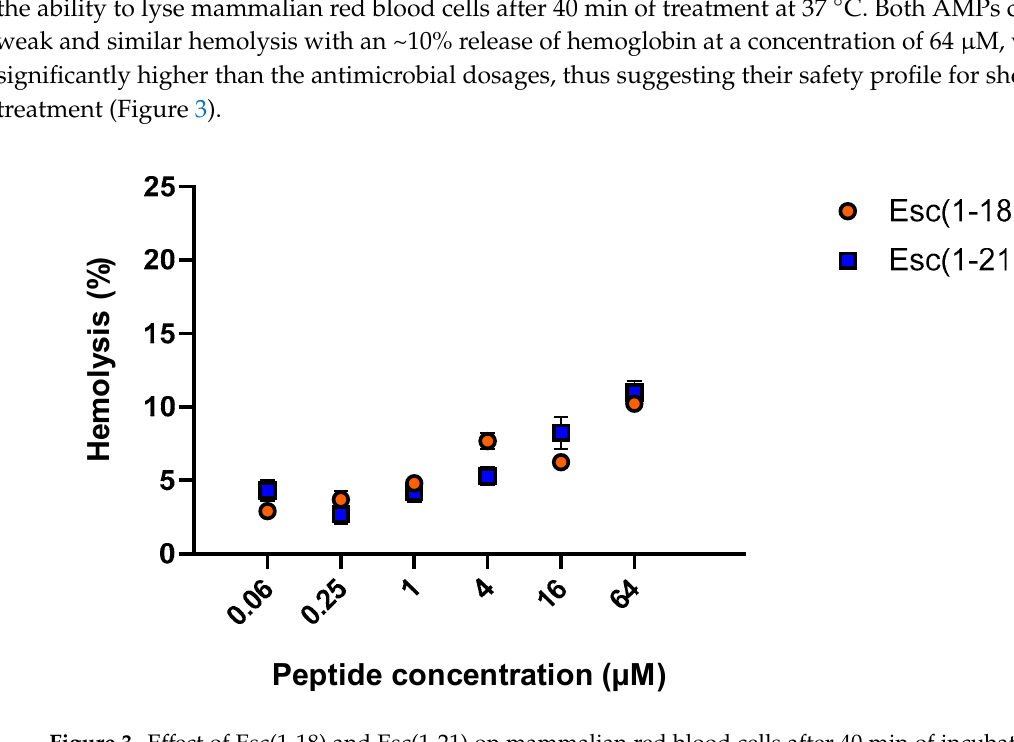
Figure 3 . Effect of Esc(1-18) and Esc(1-21) on mammalian red blood cells after 40 min of incubation at 37 °C. The percentage of hemolysis was calculated with respect to the control (cells treated with vehicle). Data are the means ± standard error of the mean (SEM) of three independent experiments.